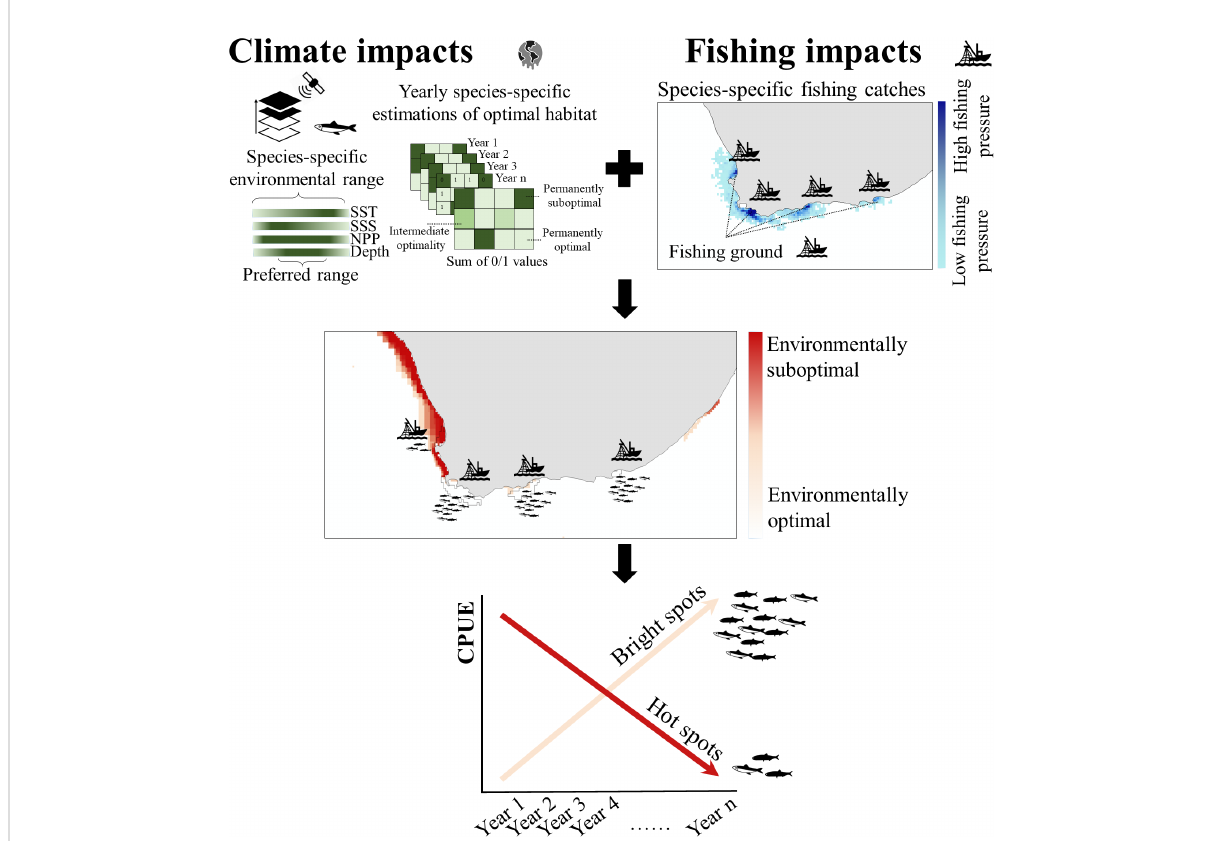
FIGURE 2 Work fl ow and work concept. Spatially-explicit assessments of climate impacts for small pelagic fi sh species combined with available data on industrial fi sh landings were used to identify highly impacted fi shing grounds (cumulative hotspots); along with those with more favorable environmental conditions (bright spots). Bright spots may provide alternative areas on which to focus fi shing activities and alleviate pressure on